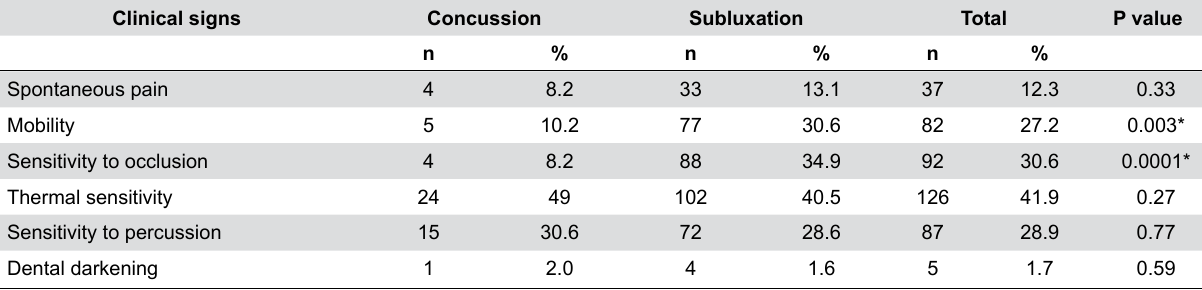
Table 4- Frequency of clinical signs in cases of concussion and subluxation